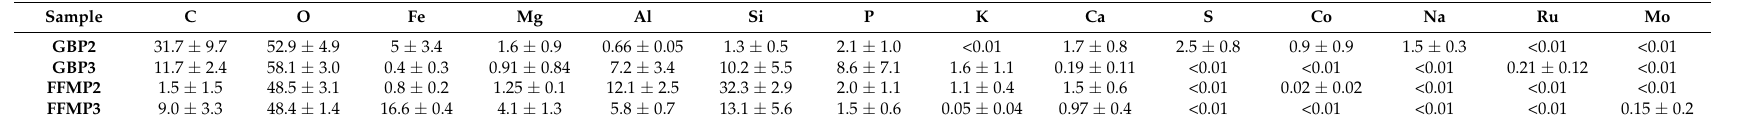
Table 4. Energy-dispersive X-ray spectroscopy (EDX) analysis of sediment samples from Gruta do Bom Pastor and Furna do Fim do Morro do Parafuso. Numbers 2 and 3 in sample identification indicate respectively drip-water-saturated samples and unsaturated sediment samples. Values in % followed by standard deviation. Sample C O Fe Mg Al Si